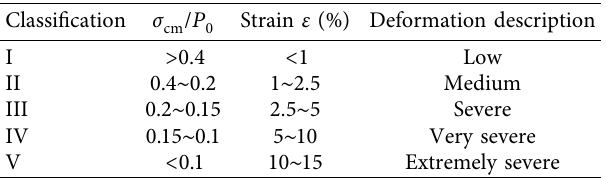
Figure 4: Support failure caused by the large deformation of the tunnel. (a) Shotcrete squeezed off. (b) Failure and deformation of steel frames. Table 1: Compressibility classification of the soft surrounding rock.